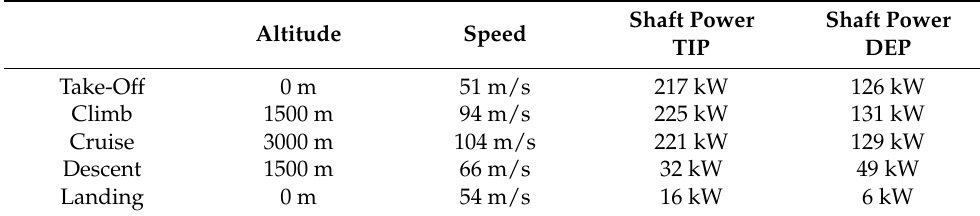
Table 5. Power requirements for each flight